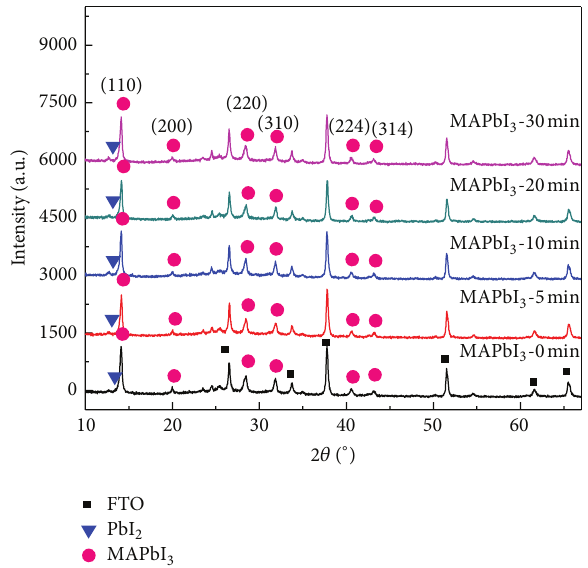
Figure 11: The IPCE curves and integrated 𝐽 sc curves of MPSCs for 0 min and 10